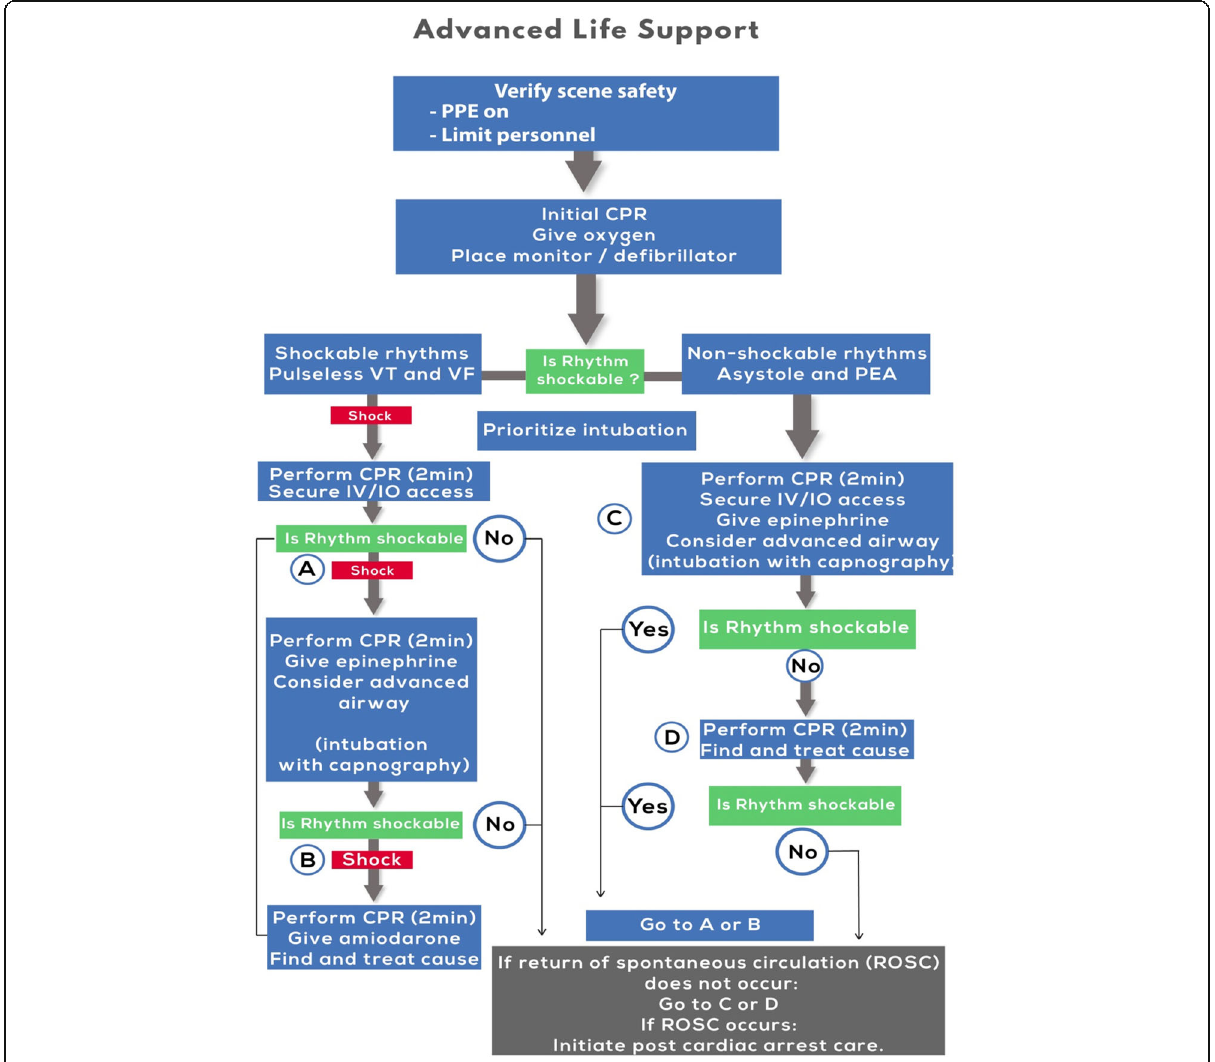
Fig. 2 Advanced cardiac life support algorithm for adults during the COVID-19